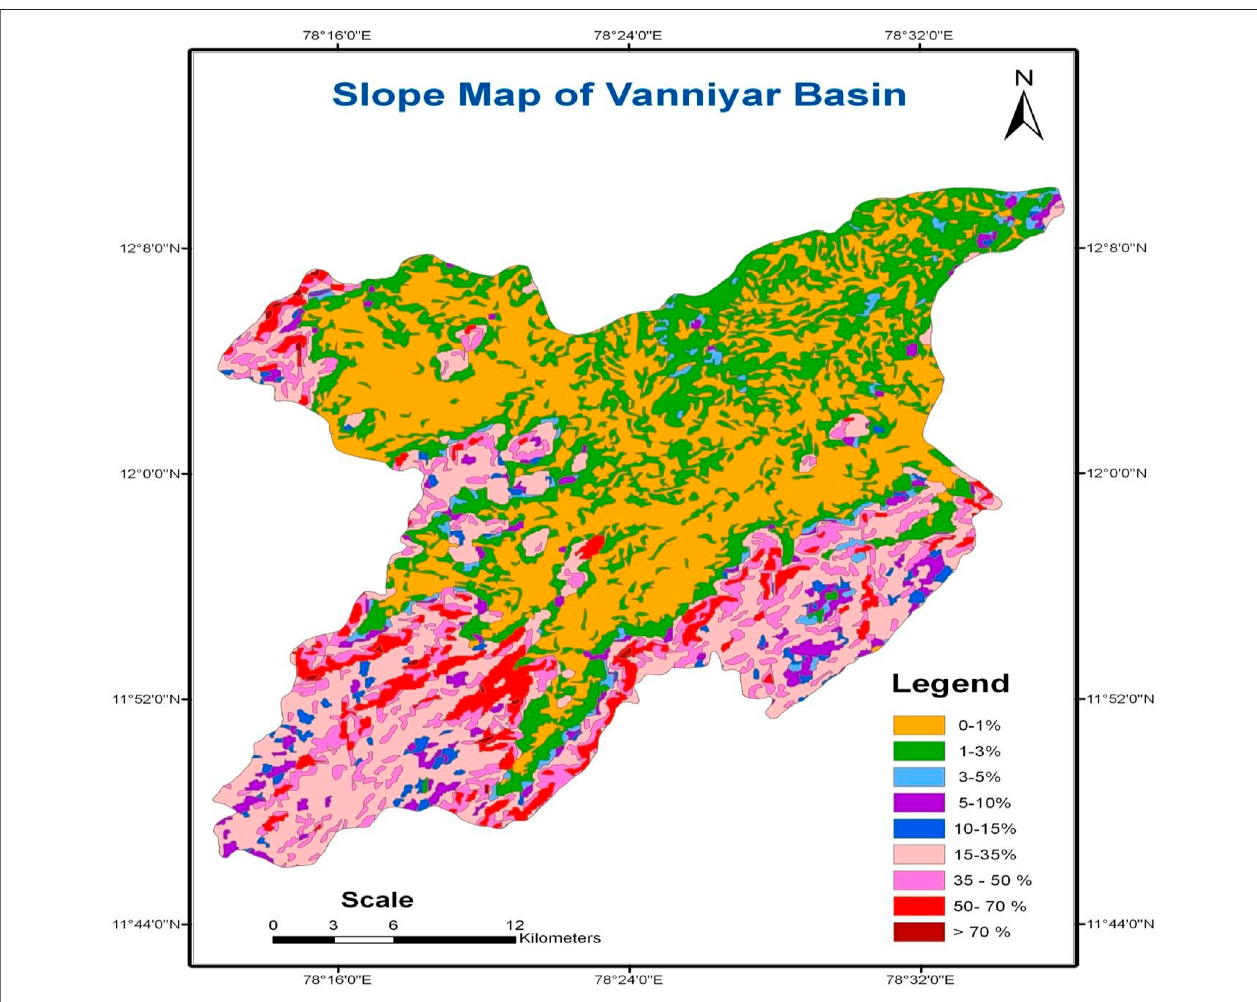
FIGURE 7 | Slope map of the Vanniyar basin, Dharmapuri district, Tamil Nadu, India.